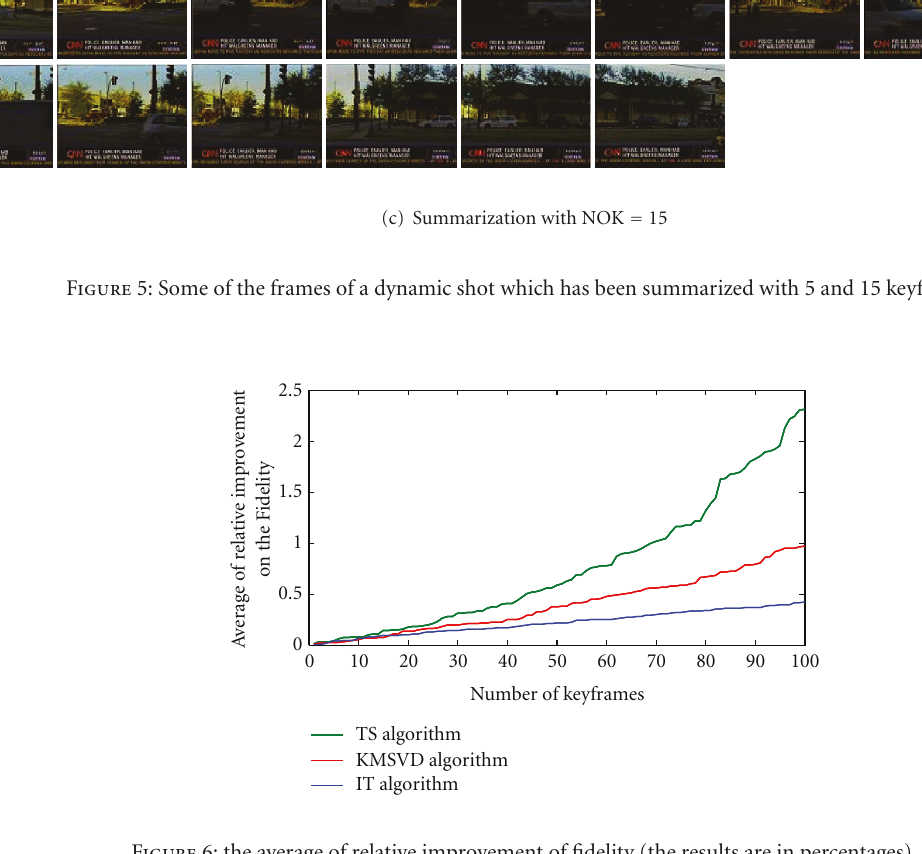
Figure 6: the average of relative improvement of fidelity (the results are in